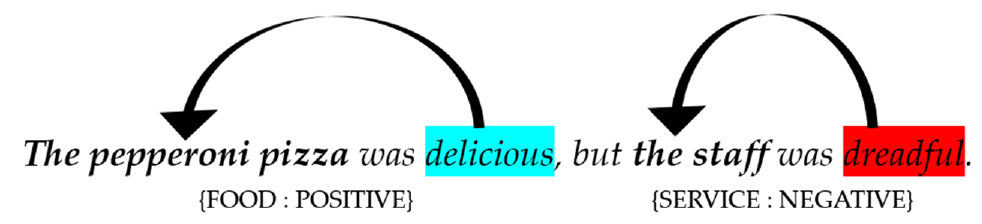
Figure 2. Another example of ABSA on a restaurant review.